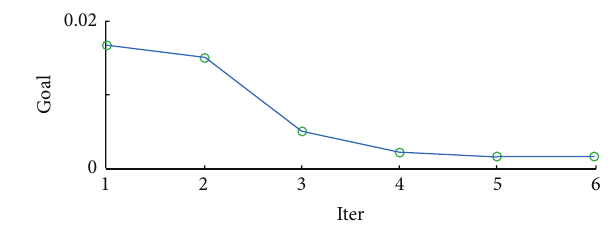
Table 3: Constraint parameters.